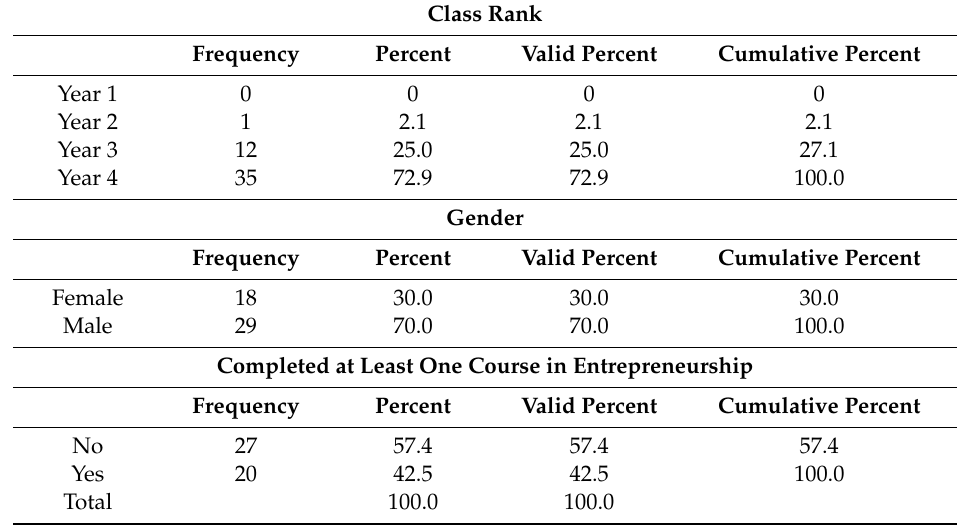
Table 6. Frequencies of covariate measures for entrepreneurial classes (class rank, gender).